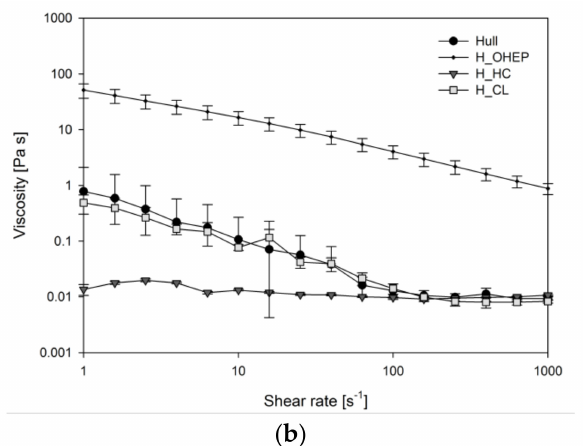
Figure 4. Viscosity of in vitro digesta containing fractionated dietary fibre (pectin-like fraction (OHEP), hemicellulose fraction (HC), cellulose-lignin fraction (CL)) derived from lupin cotyledon ( a ) and hull ( b ) of L. angustifolius L. Boregine ( n =